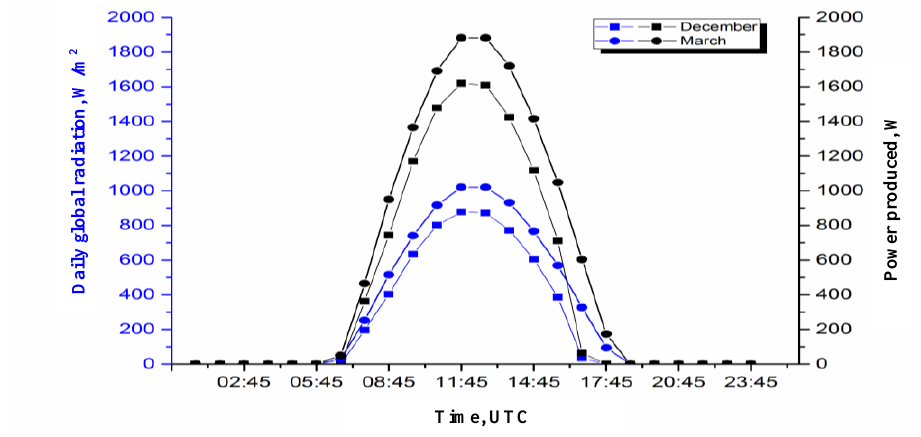
Fig. 8. Daily global radiation and electric power produced by the photovoltaic panels in